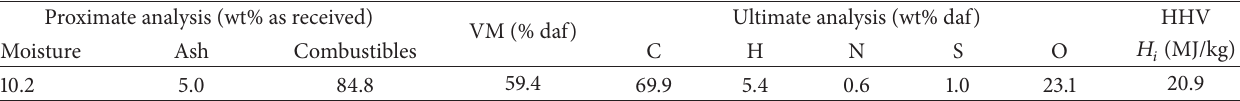
Table 1: Coal properties (Decker